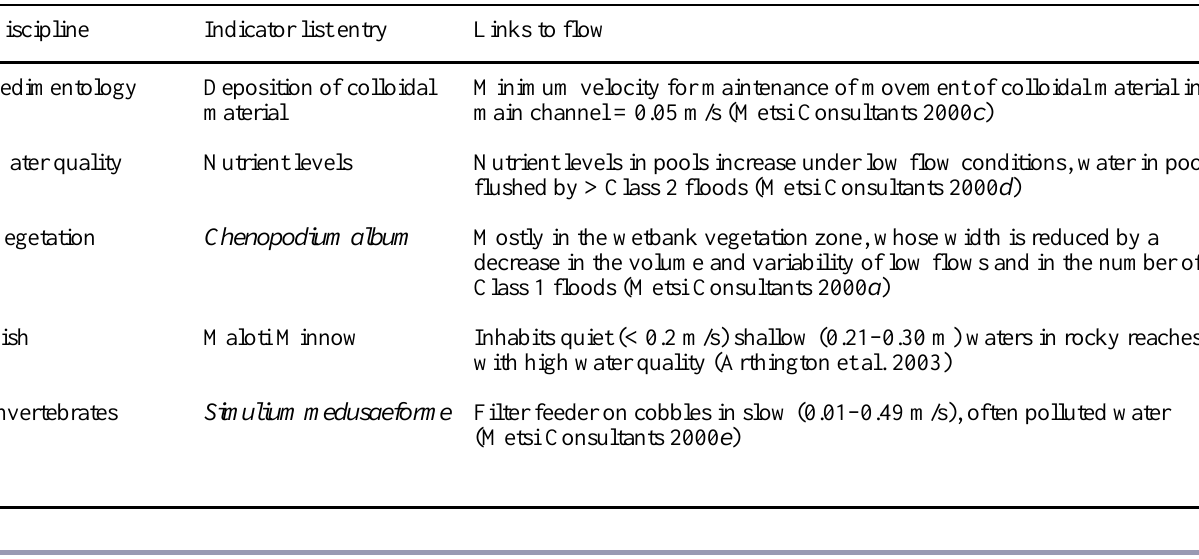
Table 6 . Examples of entries in the biophysical indicator lists for a study in